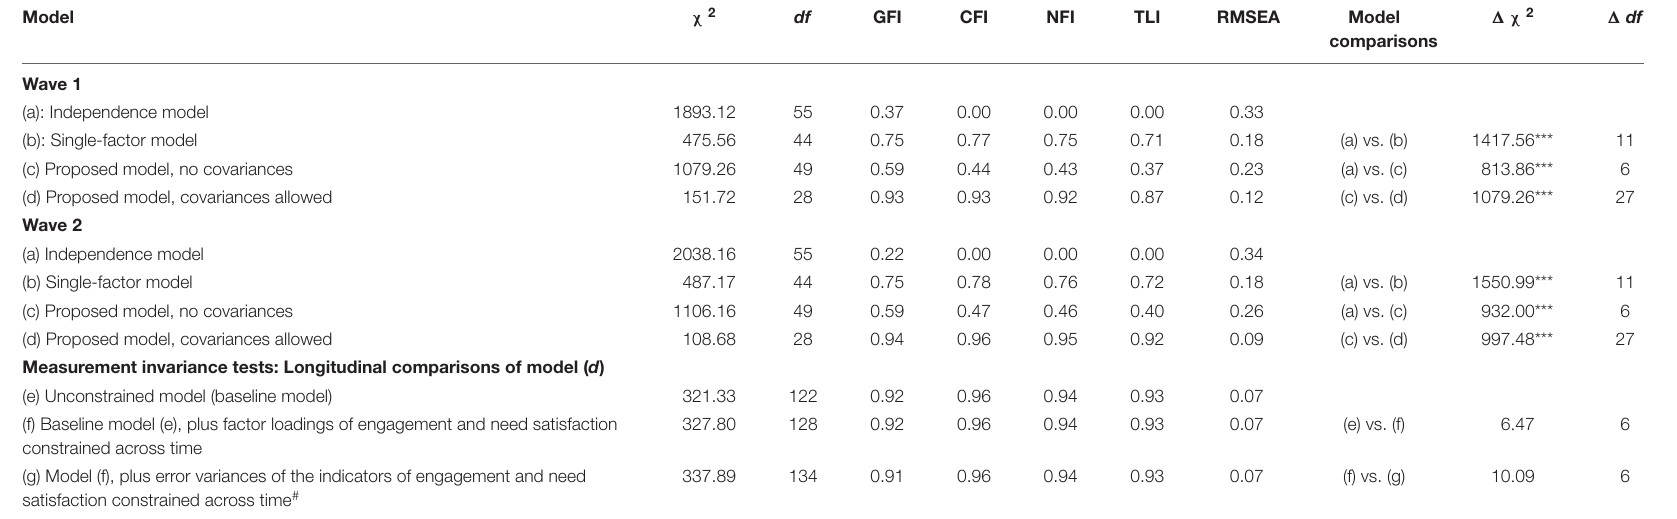
# The unstandardized loadings of the observed indicators vigor, dedication and absorption on the latent factor Work engagement were 1.08, 1.36, and 1.01, respectively, and their Time 1/Time 2 standardized loadings were 0.83 and 0.86 (vigor), 0.98 and 0.97 (dedication), and 0.80 and 0.83 (absorption). The unstandardized loadings of the observed indicators competence satisfaction, autonomy satisfaction and relatedness satisfaction on the latent factor Need satisfaction were 0.32, 0.42, and 0.63, respectively. Their Time 1/Time 2 standardized loadings were 0.50 and 0.54 (competence), 0.58 and 0.59 (autonomy) and 0.88 and 0.89 (relational). All loadings were significant at p <